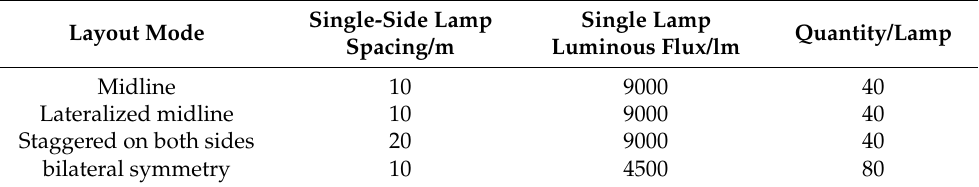
Table 5. Luminaire settings in the middle section.